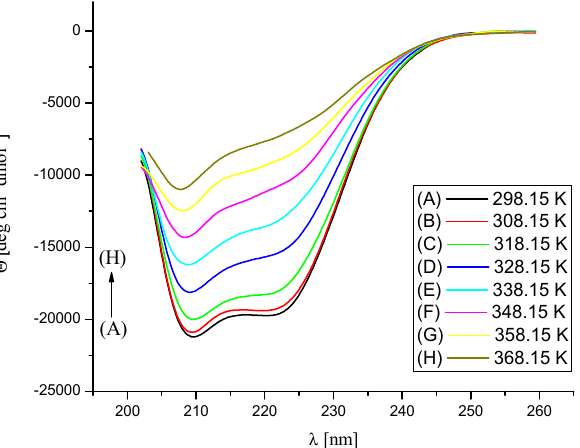
Figure 7. The raw heat capacity data for: (A) free BSA (0.015 mM) and the mixtures (B) with the Na[B(Ph) 4 ]:BSA molar ratios 2.5:1 (0.0375 mM Na[B(Ph) 4 ], 0.015 mM BSA) and (C) 7:1 (0.105 mM Na[B(Ph) 4 ], 0.015 mM BSA) in the 10 mM Caco buffer of pH 7.